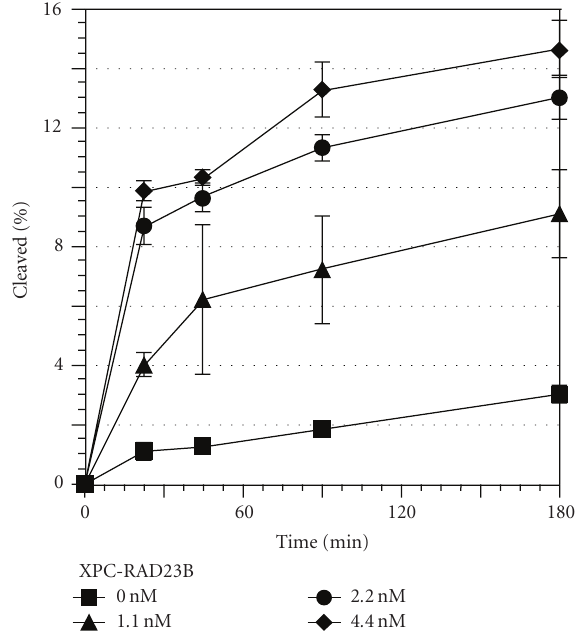
Figure 2: XPC stimulates the activity of TDG that cleaves uracil from G/U mismatches. The activity of TDG was measured by using 1.6nM of 60-bp DNA containing a single G/U mismatch as a substrate. The reaction was done at 30 ◦ C for the indicated time with 0.42 nM His-TDG in the presence of various concentrations of XPC-RAD23B. The DNA samples were then purified and subjected to alkali-treatment to cleave the resulting AP sites and separated with denaturing PAGE. The ratio of the cleaved product was calculated and plotted as a graph. The mean values and standard errors were calculated from at least two independent experiments.